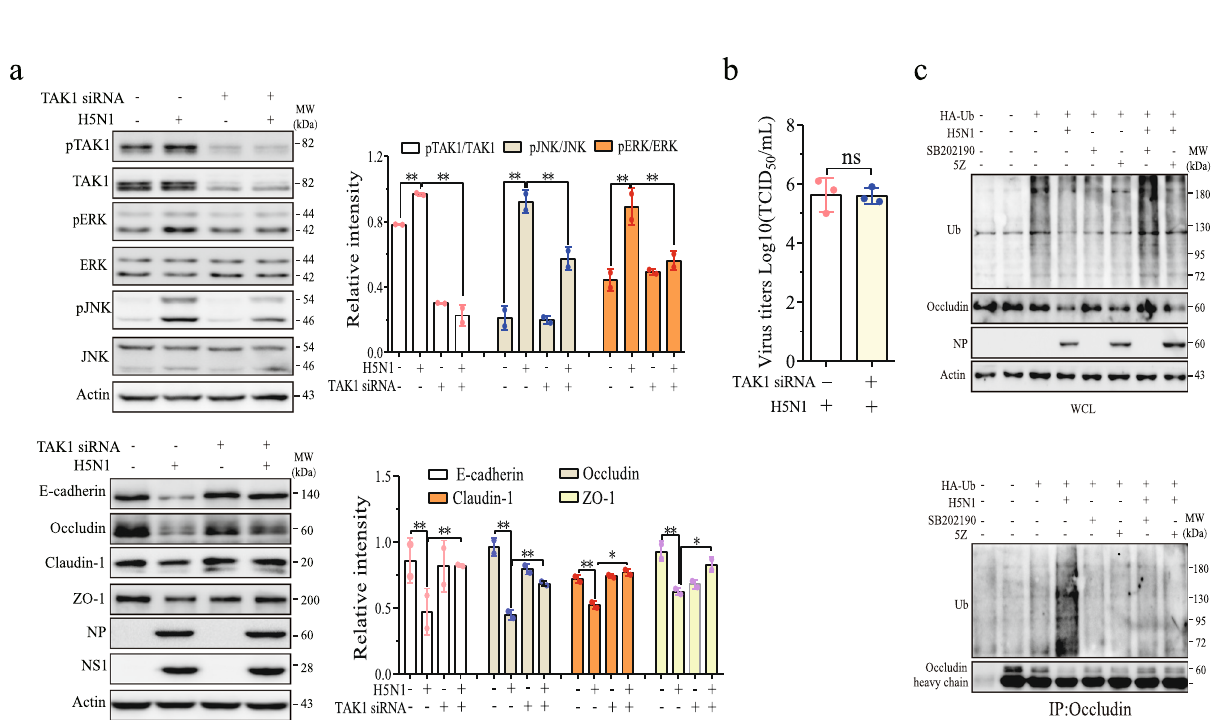
Fig. 6 Role of TAK1 in degrading junction proteins. a H5N1 viruses induce TAK1 phosphorylation. A549, MDCK, and NL20 cells were infected with various MOI of the H5N1 viruses for 24 h or with the H5N1 viruses (1 MOI) for the indicated lengths of time. Cell lysates were analyzed for the levels of TAK1 phosphorylation, NP, NS1, and β -actin by Western blot. b 5Z blocks H5N1 virus-induced Itch expression and junction protein downregulation. A549 cells were left uninfected or infected with 1 MOI of H5N1 viruses. After incubation for 12 h, 5Z (5 μ M) was added and then incubated for another 12 h. Cell lysates were analyzed by Western blot for TAK1, ERK, JNK, p38, and p65 phosphorylation and for the levels of junction proteins with their speci fi c antibodies. The density of bands was analyzed using NIH Image-J software and normalized by the arbitrary units of β -actin. Data are the mean ± SD of three experiments. *p < 0.05, **p < 0.01. c 5Z blocks H5N1 virus-induced disruption of intercellular junction structure. A549 cells seeded on coverslips were treated as above. Cells were immunostained with antibodies against occludin and claudin-1 and visualized under a confocal microscope. d Quanti fi cation of fl uorescence signals. The monolayers immunostained for occludin and claudin-1 in c were analyzed for immuno fl uorescence intensity by using Image J software. The fl uorescent signals of intercellular junctions were quanti fi ed and plotted as bar graphs. Data represent the mean ± SD of fi ve random fi elds (40X) from one of three independent experiments with similar results. e 5Z blocks the H5N1 virus-induced decrease of electronic resistance. A549 cells seeded in Transwell inserts were left uninfected or infected with H5N1 viruses. After incubation for 12 h, 5Z (5 μ M) was added and then incubated for another 12 h. TEER was measured at the indicated times. The results represent the mean ± SD of three independent experiments. ** p < 0.01.